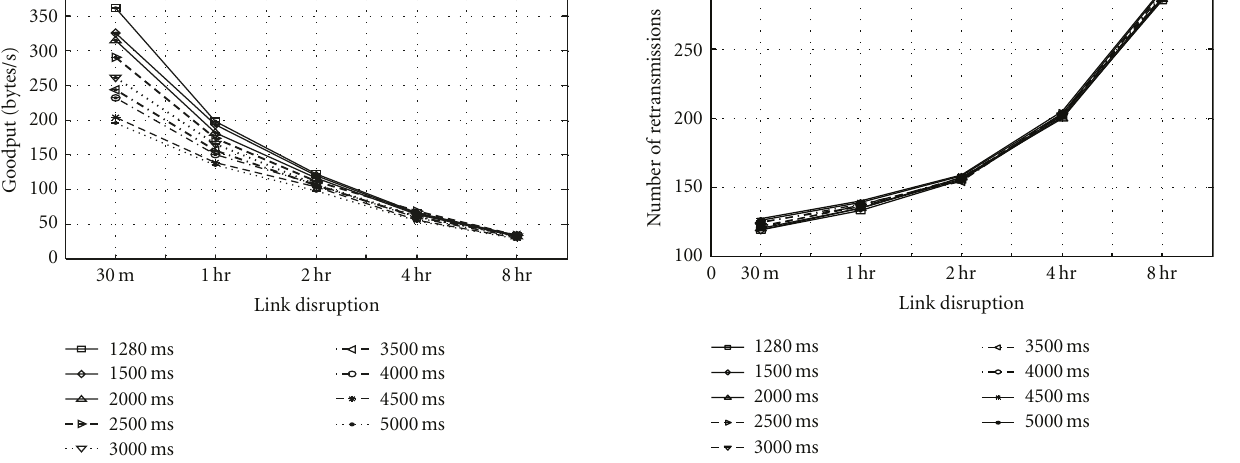
Figure 2: Comparison of goodput performance for DTN transmis- sions over cislunar channels for all link delays and link disruption at BER = 10 − 5 .